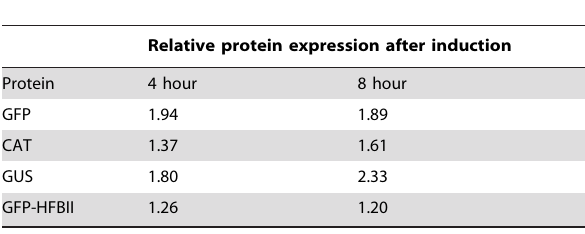
Figure 2. Relative GFP expression and mRNA, with co-expression of each repeated LEA-like peptide 4 h after induction. (a) Relative GFP expression levels and (b) mRNA levels with co-expression of each repeated LEA-like peptide 4 h after induction. The co-expressed LEA-like peptide were as follows: 1 repeat, 2 repeats, 3 repeats, 4 repeats and 6 repeats. doi:10.1371/journal.pone.0082824.g002 Table 1. The effects of the co-expression of LEA-like peptide on the protein